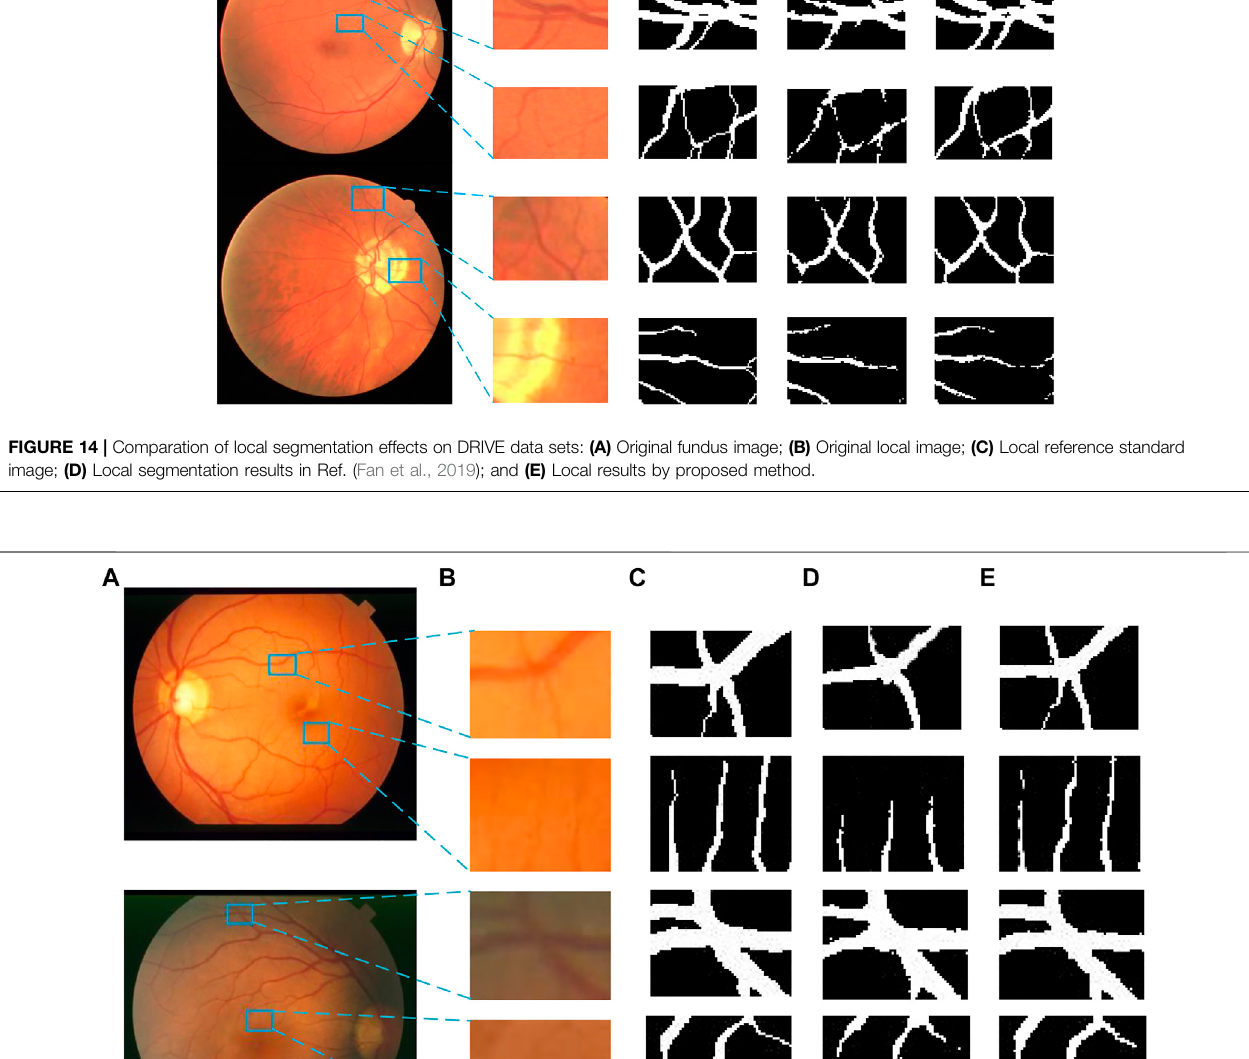
Frontiers in Bioengineering and Biotechnology |